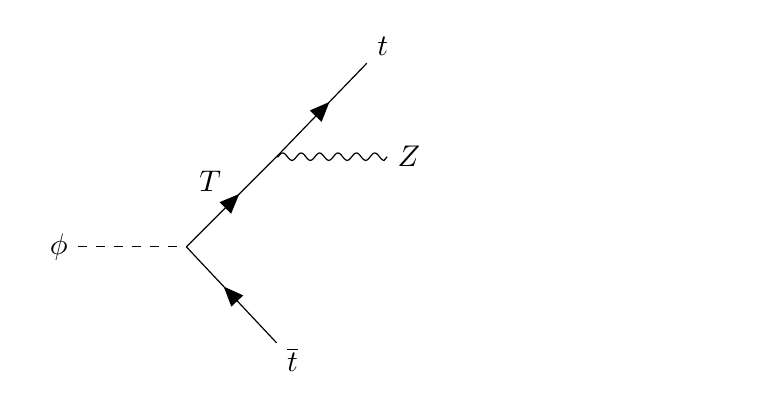
Figure 10. Feynman diagram for Yukon decay φ → ttZ .